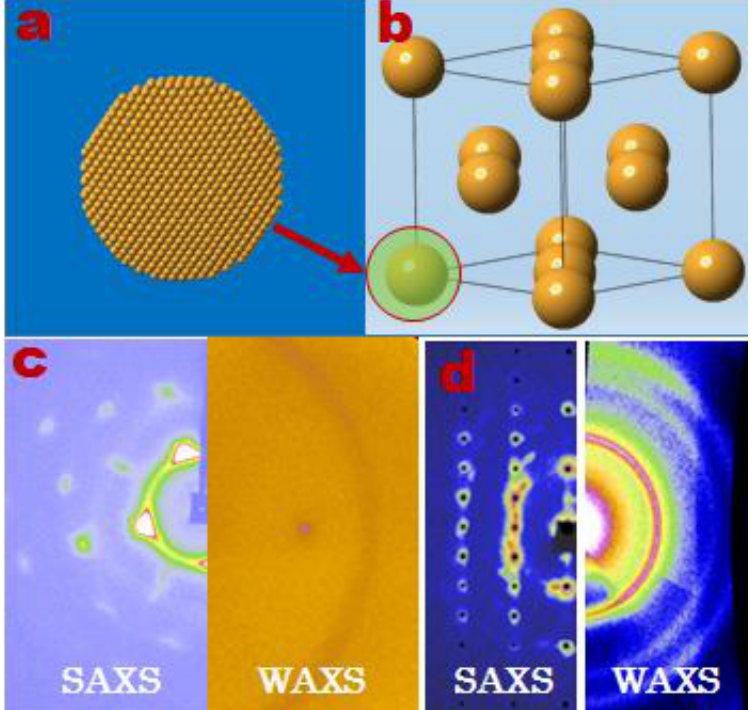
Figure 2. Self-assembly of ( a ) spherical Au NCs into either ( b,c ) a face-centered cubic (fcc) or ( d ) a hexagonal close packing (hcp) superlattice. Insert ( c , d ), left and right show SAXS and WAXS images, respectively, collected from the same volume of supercrystal at an identical orientation. Copyright of the Springe Nature group [45].